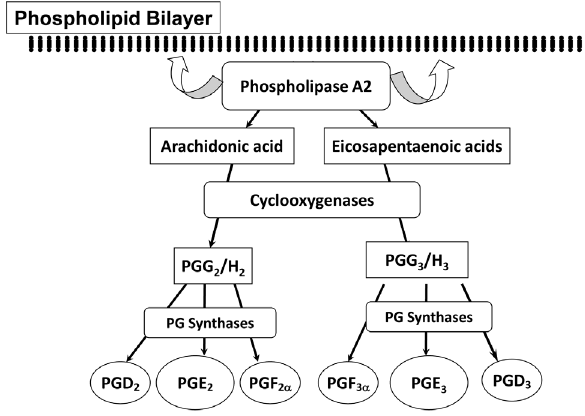
Figure 1. Biosynthesis of prostaglandin (PG) 2 series and PG3 series by AA or EPA through cyclooxygenase (COX) enzymes.